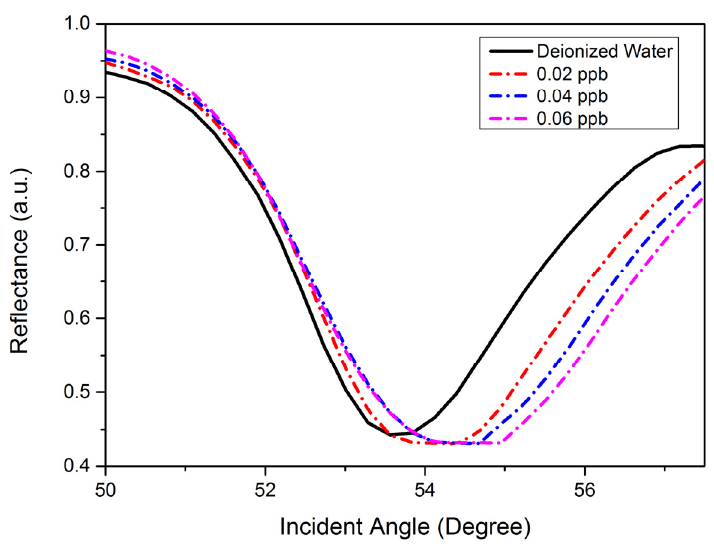
Figure 10. SPR reflectance curve for GO–PVA thin film in contact with various concentrations of carbaryl (0.02 ppb to 0.06 ppb).